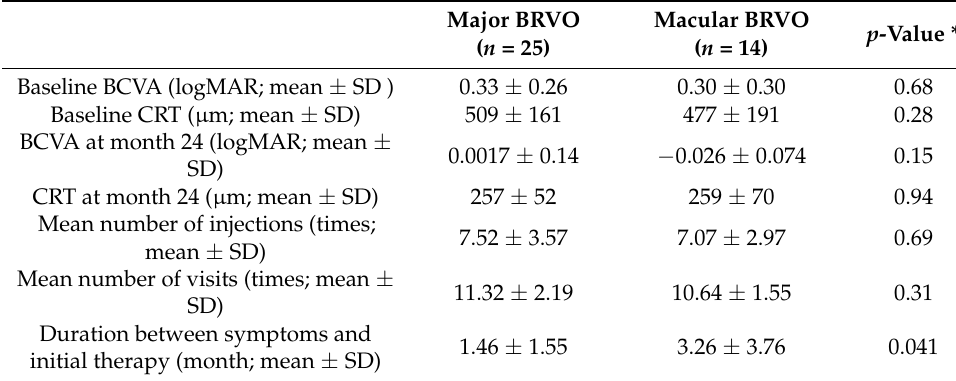
Table 2. Comparison of major BRVO and macular BRVO.